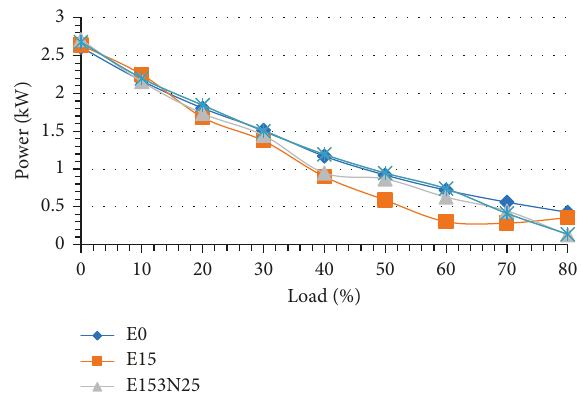
Figure 12: The effect of three elemental nanoparticles in E15 on engine power.